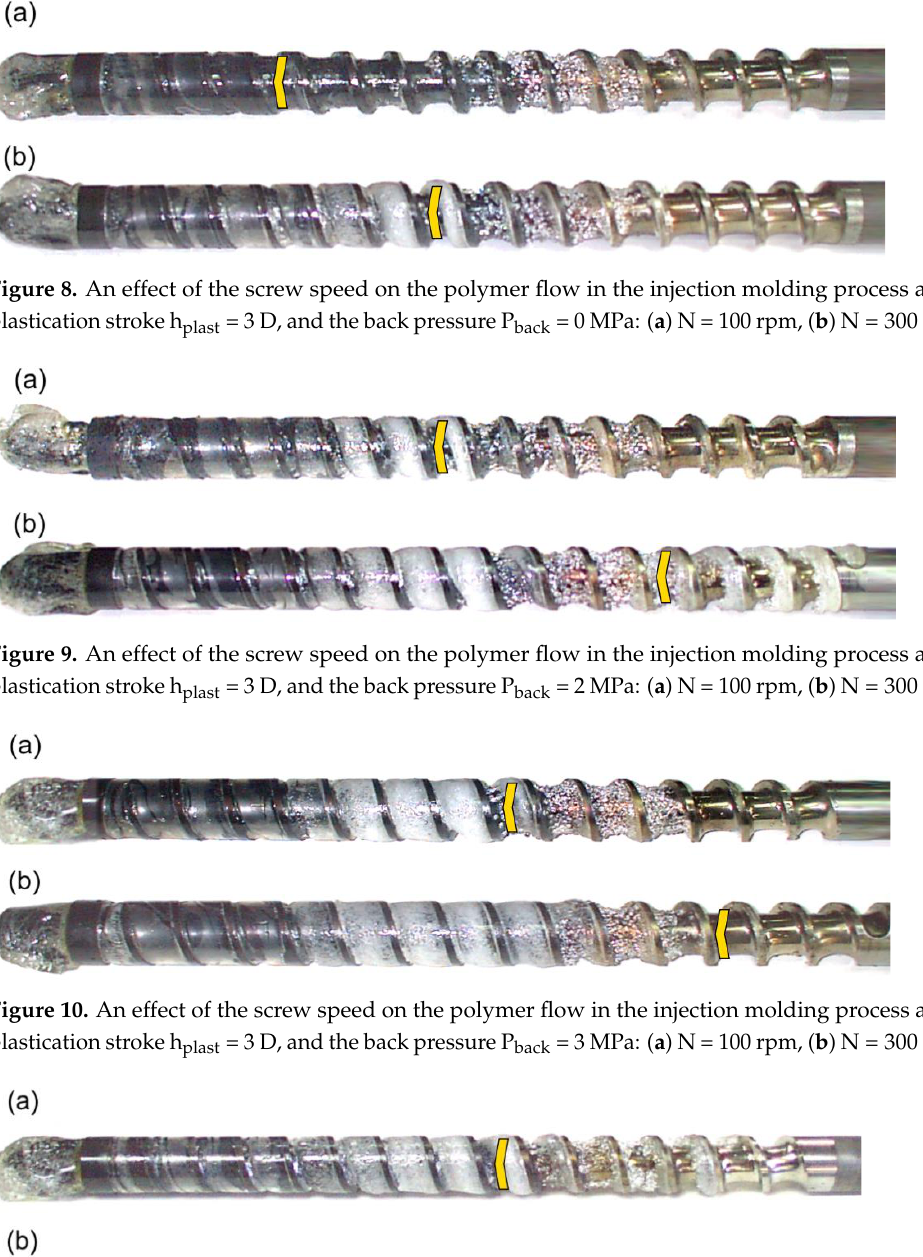
Figure 12. An effect of the plastication stroke on the polymer flow in the injection molding process at the screw speed N = 100 rpm, and the back pressure P back = 2 MPa: ( a ) h plast = 1 D, ( b ) h plast = 3 D.